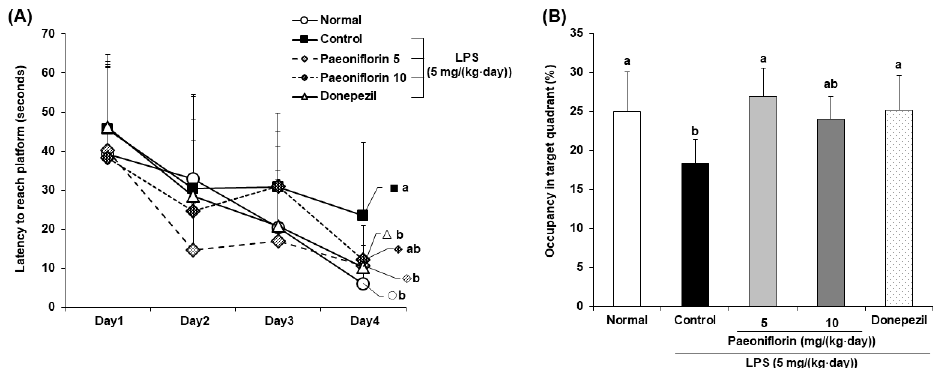
Figure 3. Effect of paeoniflorin on the spatial memory ability by a Morris water maze test in LPS- injected mice. ( A ) Effect of paeoniflorin on the escape latency to the platform in the Morris water maze test. ( B ) Effect of paeoniflorin on occupancy time in the target quadrant. The percentage of time spent in the target quadrant was calculated in the water maze test on the final test day. Data represent the mean ± SD. a,b Means with different letters are significantly different ( p < 0.05) by a Duncan’s multiple range test. Normal group = 0.9% NaCl i.p. ; Control group = LPS (5 mg/(kg ∙ day)) i.p. + 0.9% NaCl i.p. ; Paeoniflorin 5 group = LPS (5 mg/(kg ∙ day)) i.p. + paeoniflorin (5 mg/(kg ∙ day)) i.p. ; Paeoniflorin 10 group = LPS (5 mg/(kg ∙ day)) i.p. + paeoniflorin (10 mg/(kg ∙ day)) i.p. ; Donepezil group = LPS (5 mg/(kg ∙ day)) i.p. + donepezil (5 mg/(kg ∙ day)) i.p.